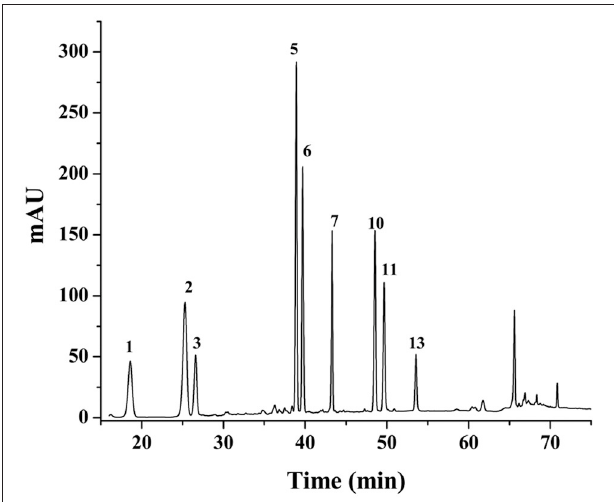
FIGURE 5 | The chromatograms of the mixture of reference substances. Peak 1, 2, 3, 5, 6, 7, 10, 11, and 13 correspond to notoginsenoside R 1 , ginsenosides Rg 1 , Re, Rh 1 , Rb 1 , Rd, Rk 3 , Rh 4 , and 20( R )-Rg 3 ,